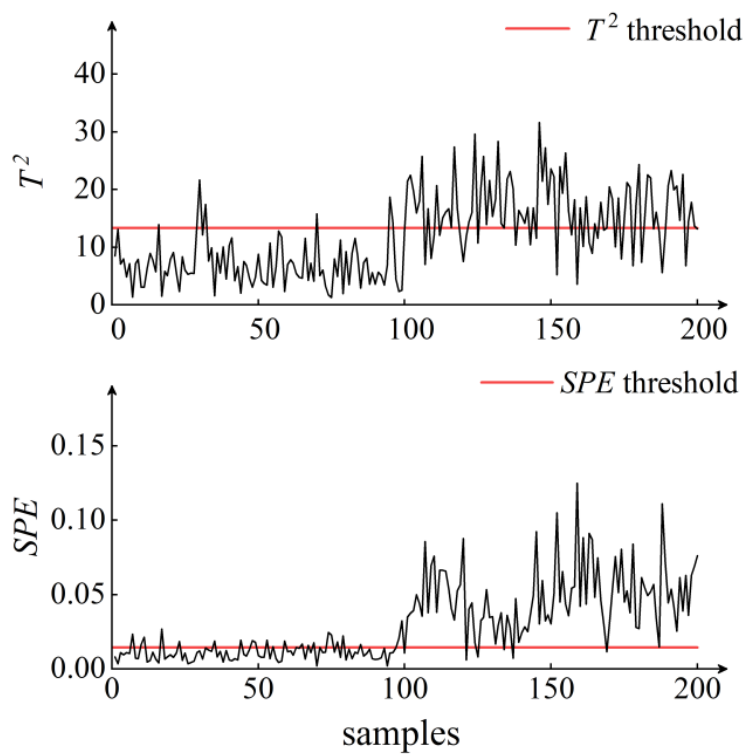
Figure 15. W-KPLS monitoring of sample 2.